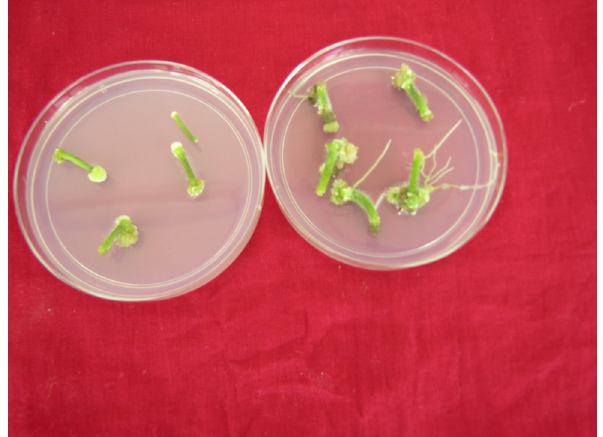
C.D = Genotypes- 0.71, Hormone concentrations-0.16, Hormone x Genotypes-0.22 Fig. 1. Hypocotyl explants on MS + 0.5 kinetin + 0.5